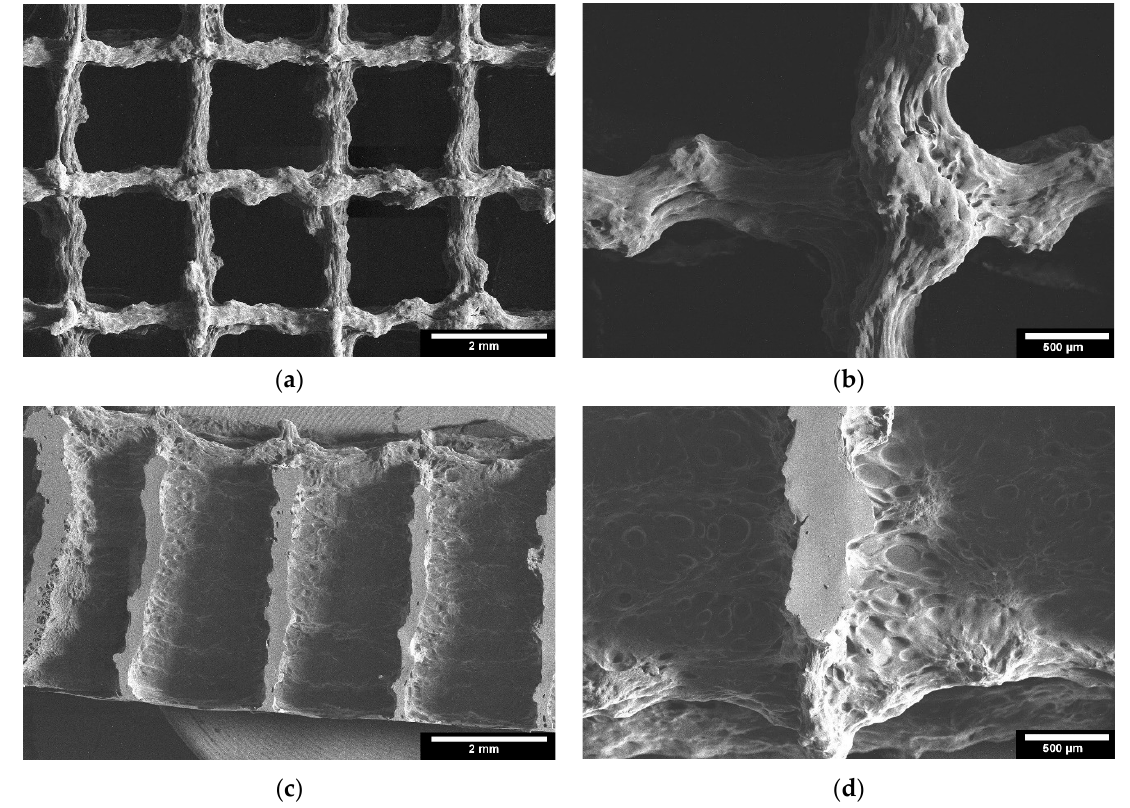
Figure 6. ESEM images of the 3D printed TC scaffolds; 3D printed TC scaffolds top view: